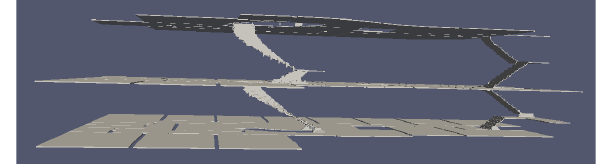
Figure 6. The surface skeleton of the navigable